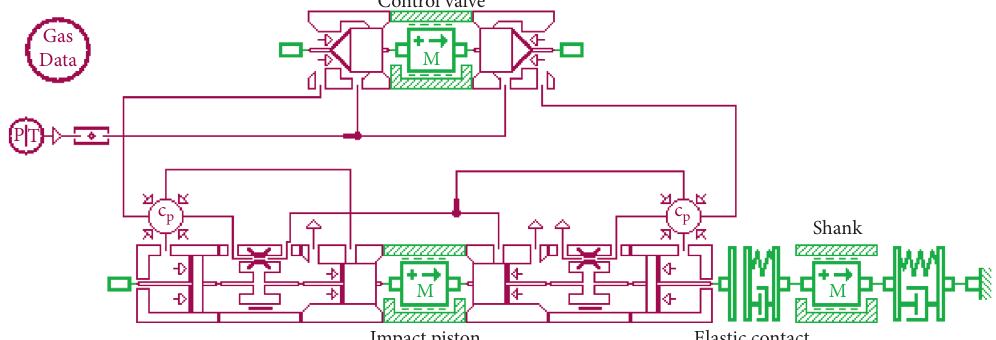
Figure 3: AMESim simulation model of the proposed pneumatic hammer.